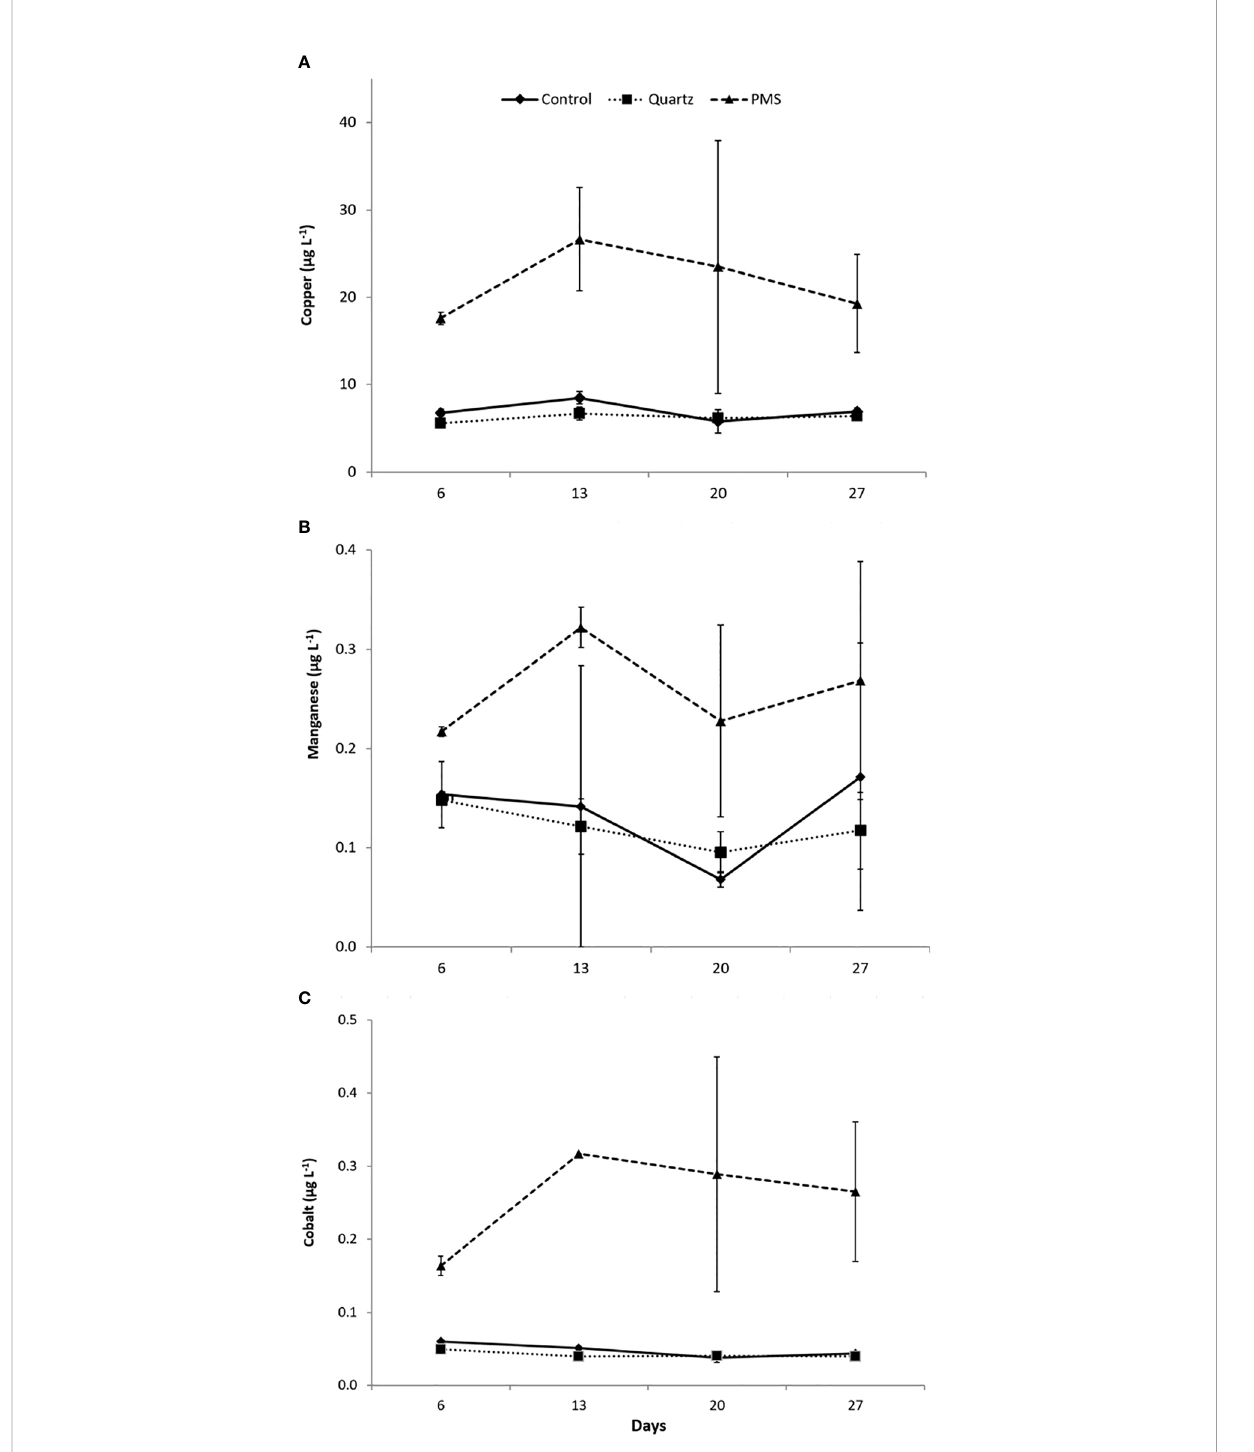
FIGURE 2 (A-C) Trace metal concentration in seawater in the treatments with polymetallic sulphide particles (PMS), with quartz particles (Quartz) and a control treatment with no sediment addition at times 6,13, 20 and 27 days of the experiment. N=2, data expressed as mean ± standard